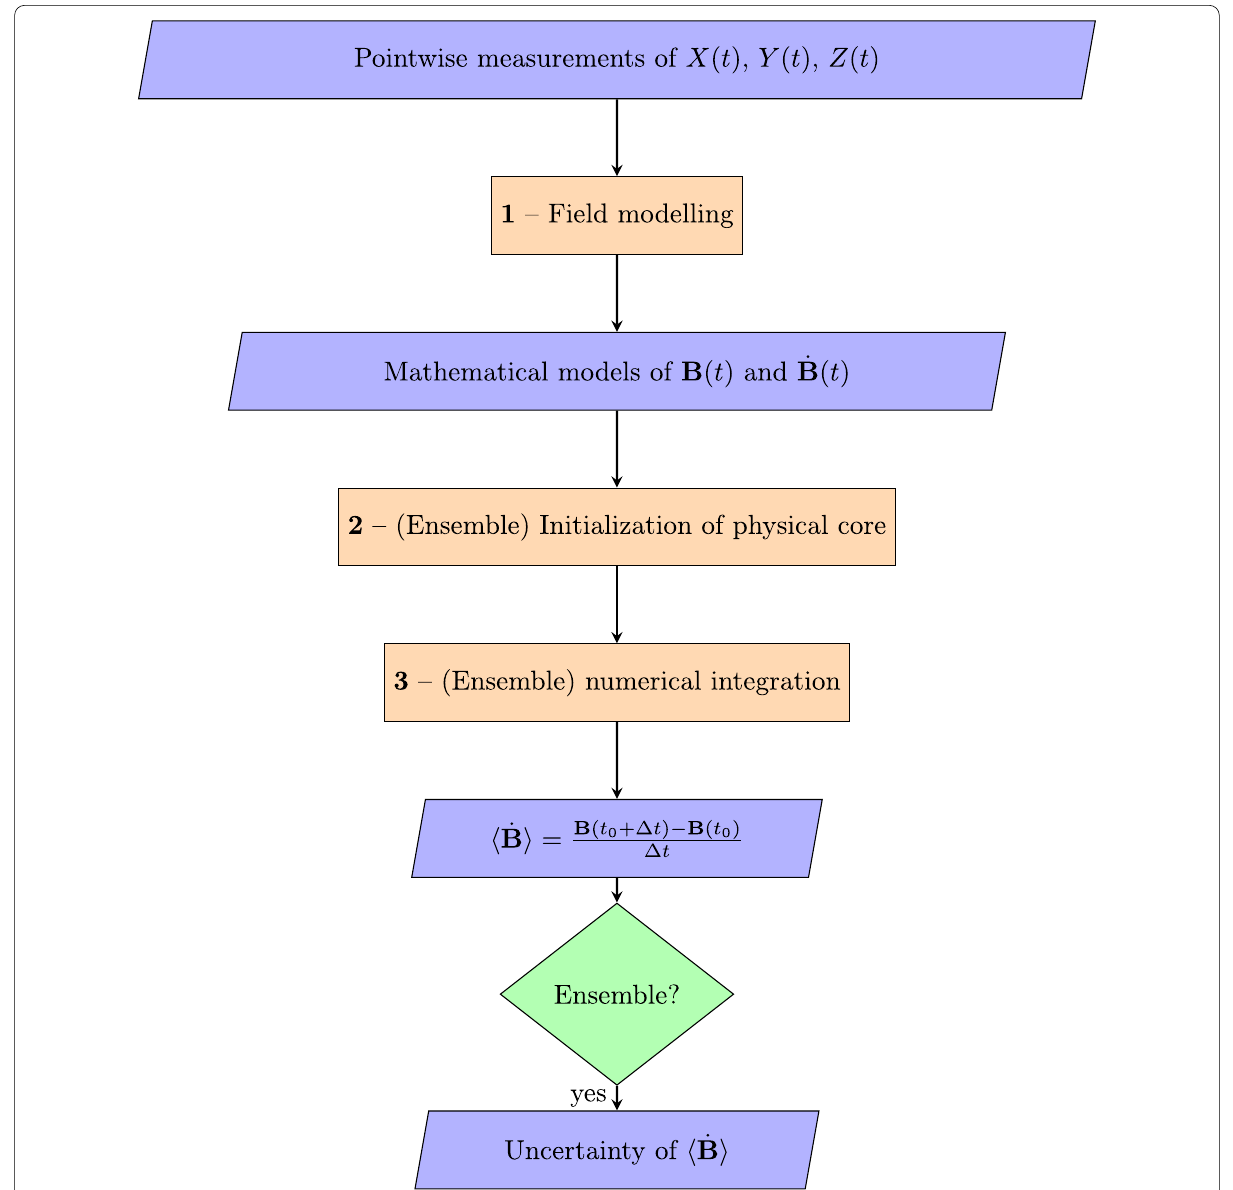
Fig. 4 Flowchart summarizing the steps currently involved in the making of a physics-based secular variation candidate model. X ( t ), Y ( t ), Z ( t ) are the three components of the magnetic field vector recorded in an observatory or by a satellite. Field modelling refers to the process that converts databases of these time series into global mathematical models of the main magnetic field B ( t ) and its rate of change ˙ B ( t ) . These mathematical models are fed, together with their uncertainty, to a workflow that initializes the state vector (or ensemble of state vectors) for subsequent integration by the numerical model. The average secular variation between the start date of the IGRF ( t 0 ) and its end ( t 0 evaluated. If an ensemble approach is used, an ensemble of such average secular variations are obtained, the statistics of which can be used